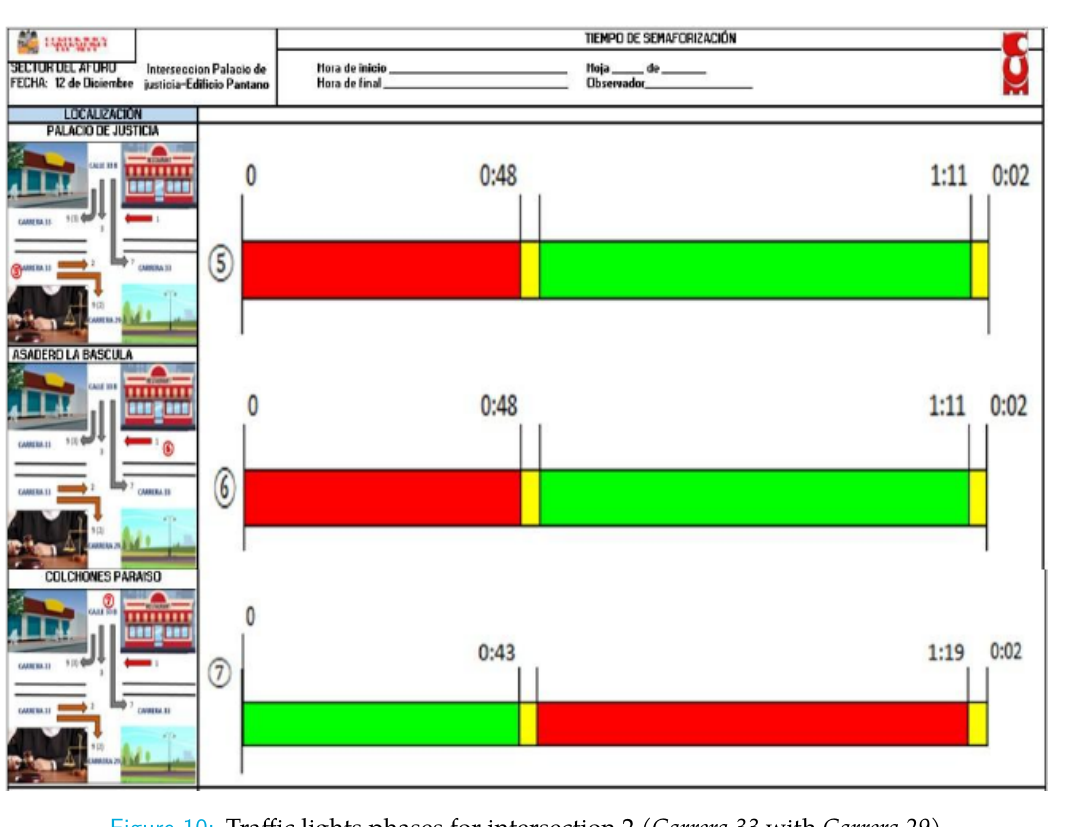
Figure 10: Traffic lights phases for intersection 2 ( Carrera 33 with Carrera 29 )